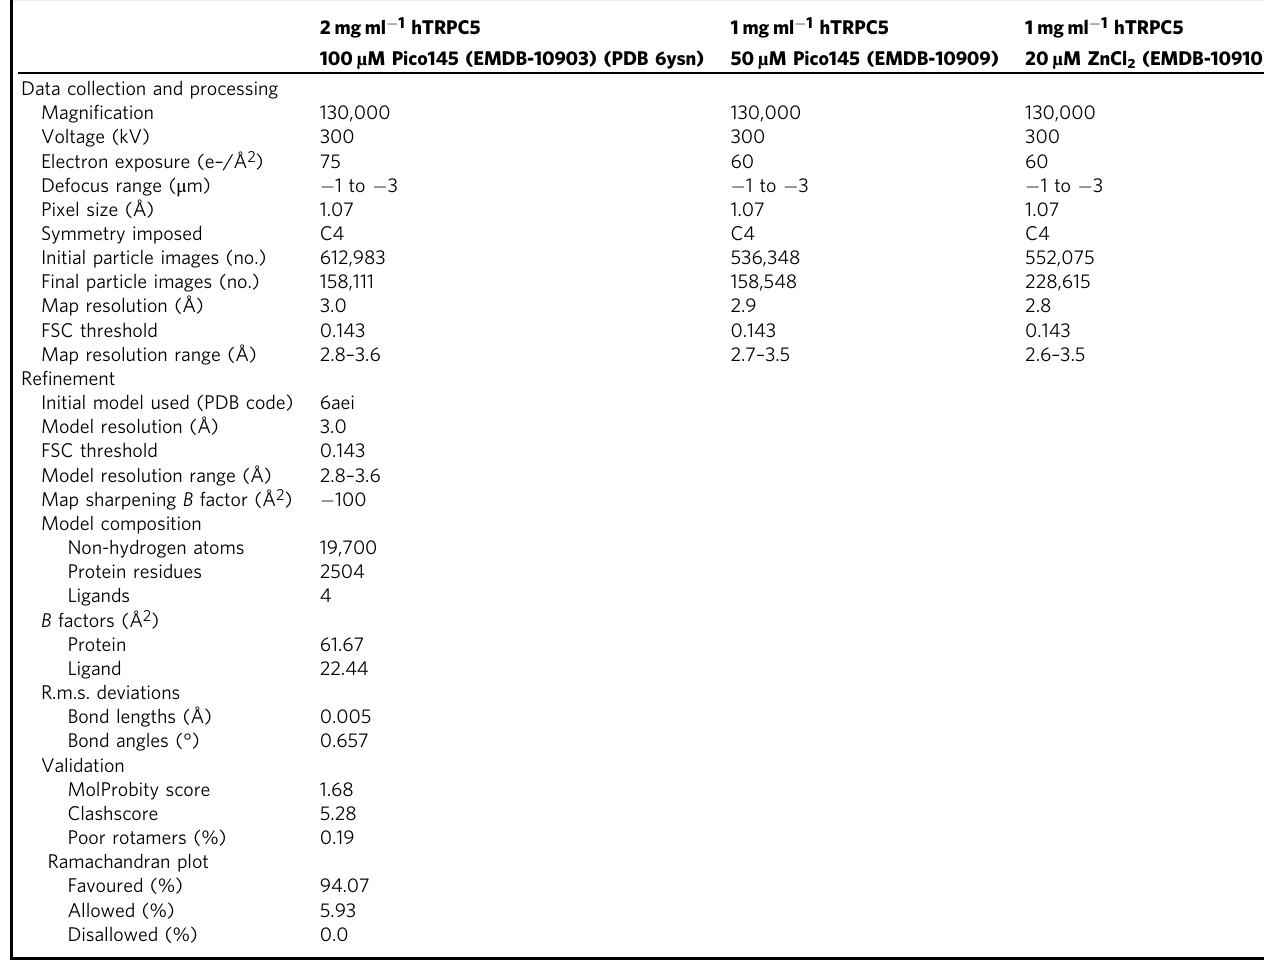
Table 1 Cryo-EM data collection, re fi nement and validation